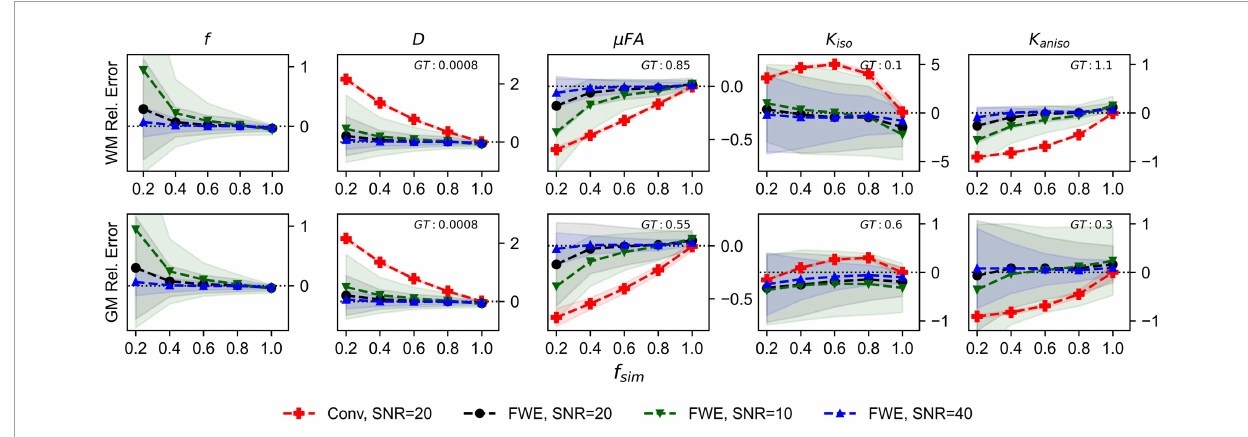
FIGURE2 Relative error in diffusion MRI indices measured in synthetic white matter (WM) and gray matter (GM) voxels at various SNR levels and a free water diffusivity of 3 e − 3 mm 2 / s . The x -axis depicts the simulated volume fraction ( f sim ), while the ground truth value for each metric is denoted as GT. The red line with crosses indicates the mean measurements made using the conventional (Conv) method at SNR = 20, the black line with circles depicts the FWE method at SNR = 20, the green line with inverted triangles depicts the FWE method at SNR = 10, and the blue line with triangles depicts the FWE method at SNR =